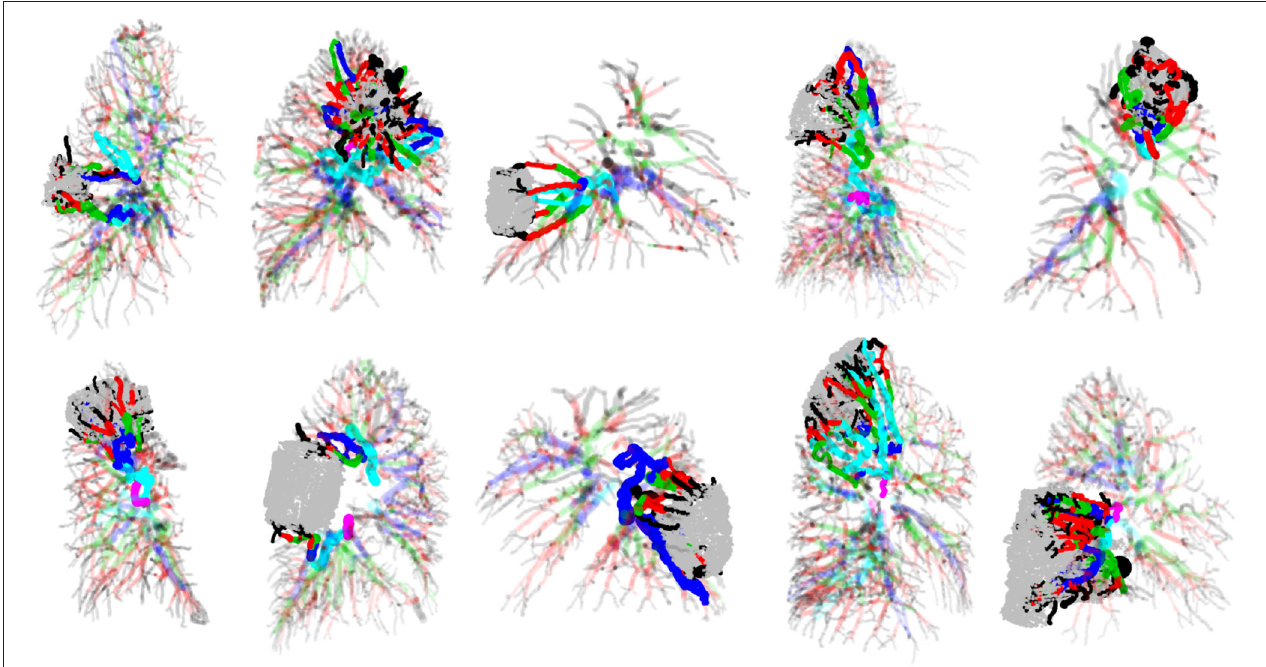
FIGURE 5 | Examples of tumors, the pulmonary vasculature in which they are embedded and supplied by, and remaining pulmonary vasculature of the lungs. Tumors are the rounded shapes colored in gray, and vessels are cylindrical shapes colored according to HS generation labeling. Tumor-supplying vasculature is drawn in full-color with zero transparency, while healthy-tissue supplying vasculature are drawn in color but with partial